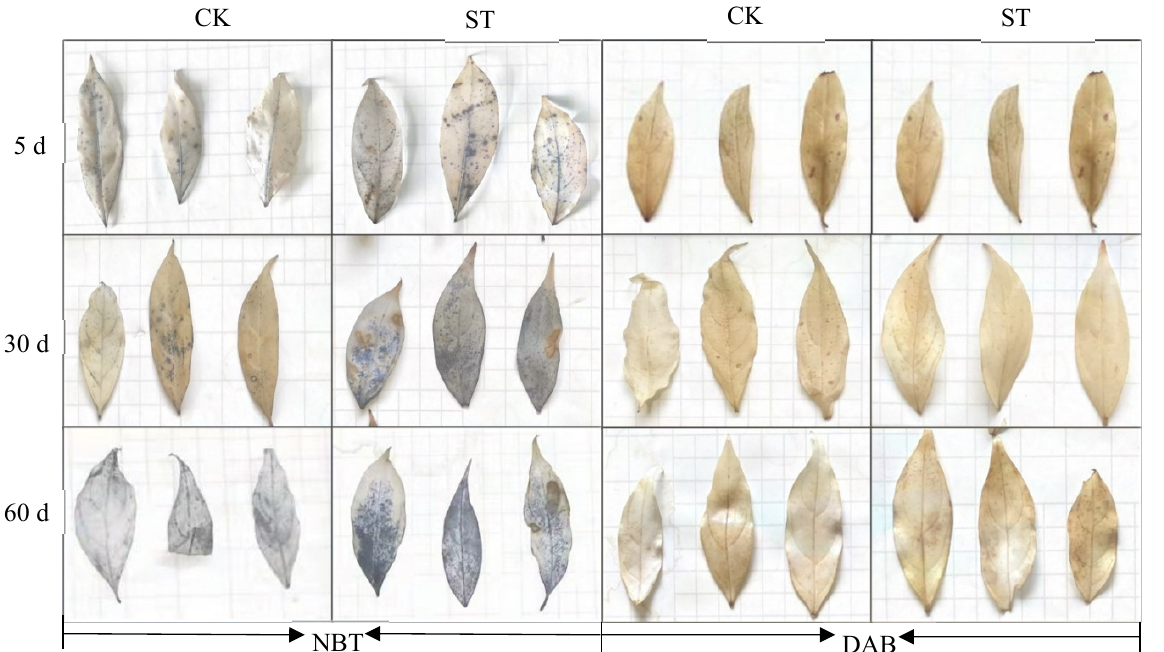
Figure 3. Changes in ROS accumulation in leaves of C. hongkongensis subsp. tonkinensis under salt stress.